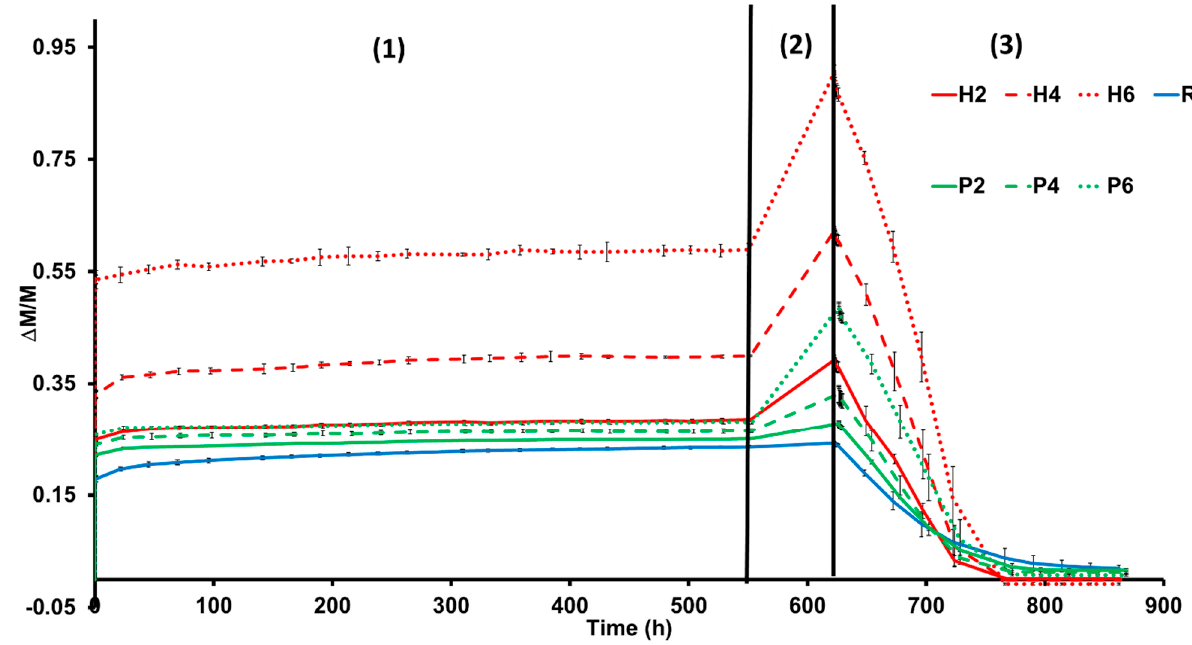
Figure 6. Free water absorption (1), forced water absorption (2) and drying (3) of bricks made without additives (R), with the addition of EPS (P2, P4 and P6) or olive stones (H2, H4 and H6). Weight variation ( Δ M/M) against time (in hours). Each curve represents the mean of three measurements. Brick abbreviations are indicated in Table 1. Table 3. Hydric parameters and MIP results for bricks with no additives (R), with EPS (P2, P4